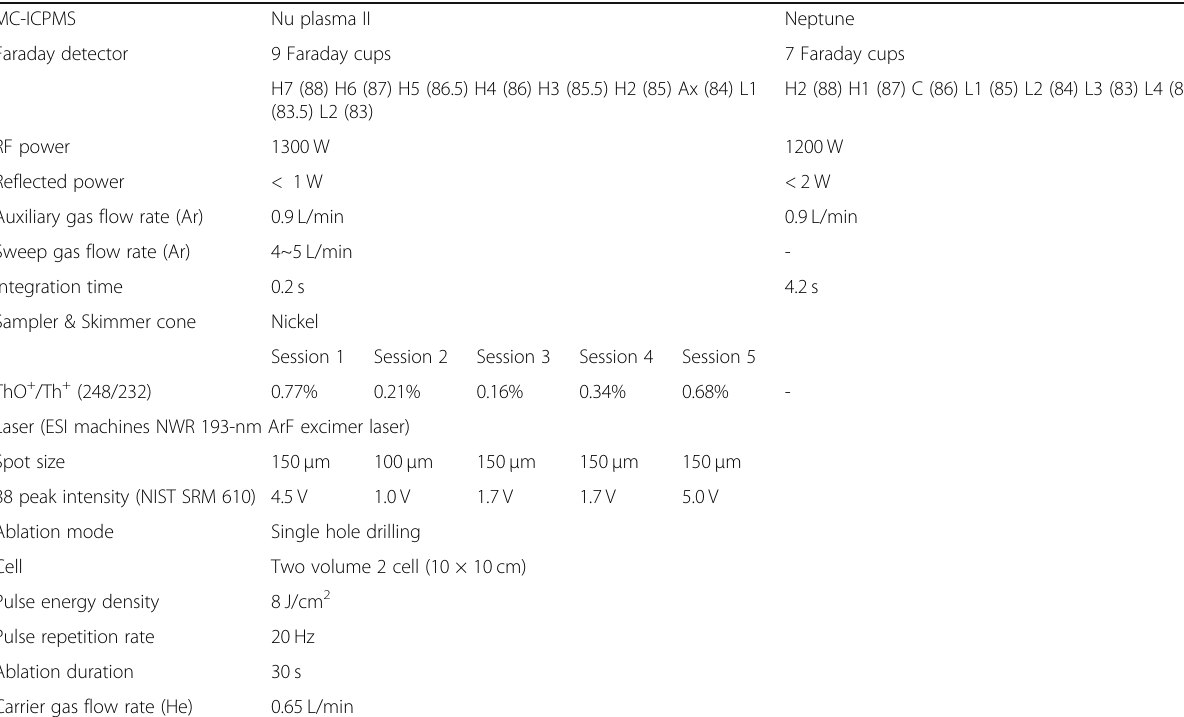
Table 1 (LA)-MC-ICPMS instrument operating parameters